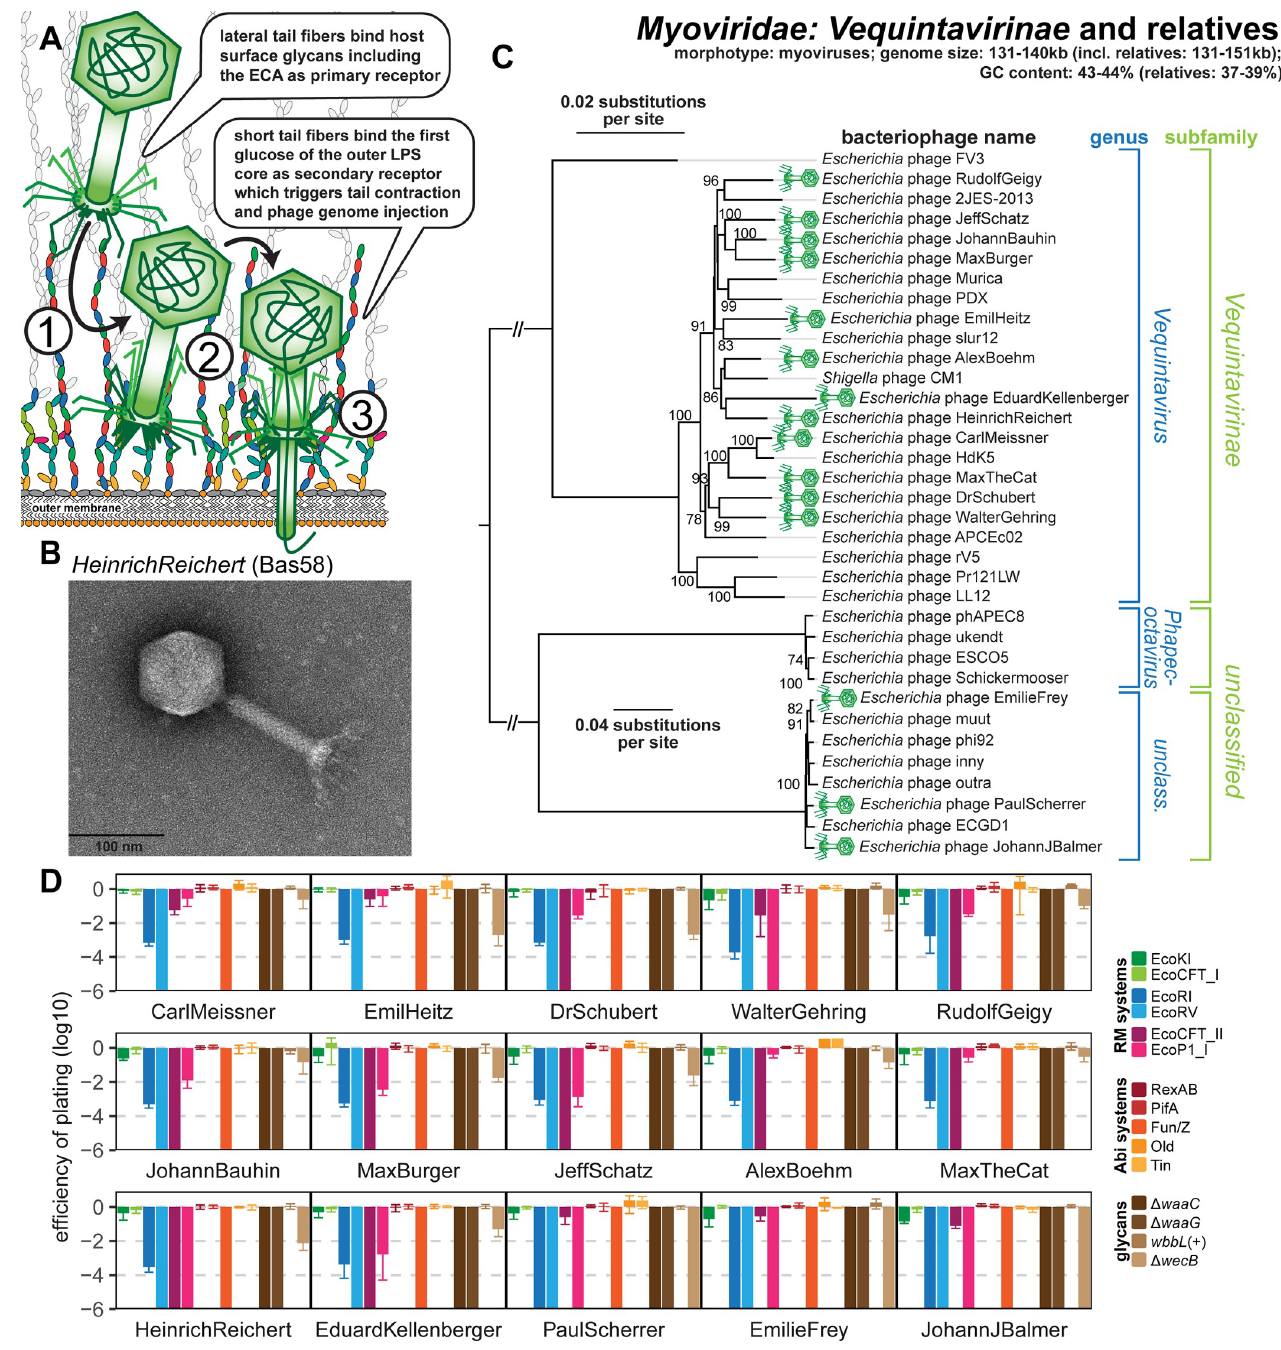
Fig 8. Overview of the Myoviridae subfamily Vequintavirinae and relatives. (A) Schematic illustration of host recognition by Vequintavirinae and related myoviruses. (B) Representative TEM micrograph of phage HeinrichReichert (Bas58). (C) Maximum-Likelihood phylogeny of the Vequintavirinae subfamily of Myoviridae and relatives based on a curated whole-genome alignment with bootstrap support of branches shown if > 70/100. The phylogeny was rooted between the Vequintavirinae sensu stricto and the 2 closely related, formally unclassified groups at the bottom. Newly isolated phages of the BASEL collection are highlighted by green phage icons. (D) The results of quantitative phenotyping experiments with Vequintavirinae and their phi92-like relatives regarding sensitivity to altered surface glycans and bacterial immunity systems are presented as EOP. Data points and error bars represent average and standard deviation of at least 3 independent experiments. Raw data and calculations are available in S1 Data. Abi, abortive infection; BASEL, BActeriophage SElection for your Laboratory; ECA, enterobacterial common antigen; EOP, efficiency of plating; LPS, lipopolysaccharide; RM, restriction–modification; TEM, transmission electron